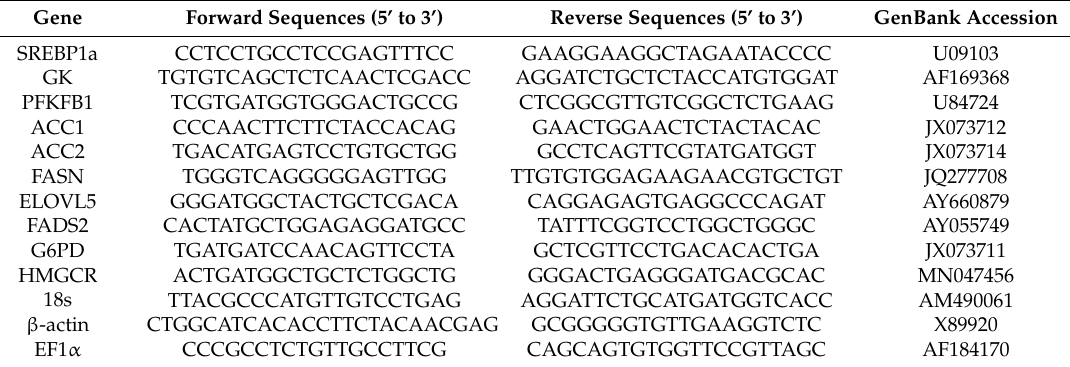
Table 2. Primer sequences used for reverse transcriptase-coupled quantitative real time PCR (RT-qPCR) in the present